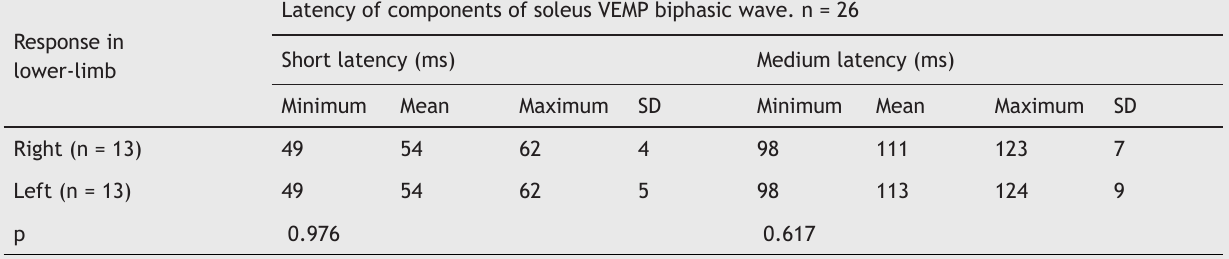
stimulation of the mastoid